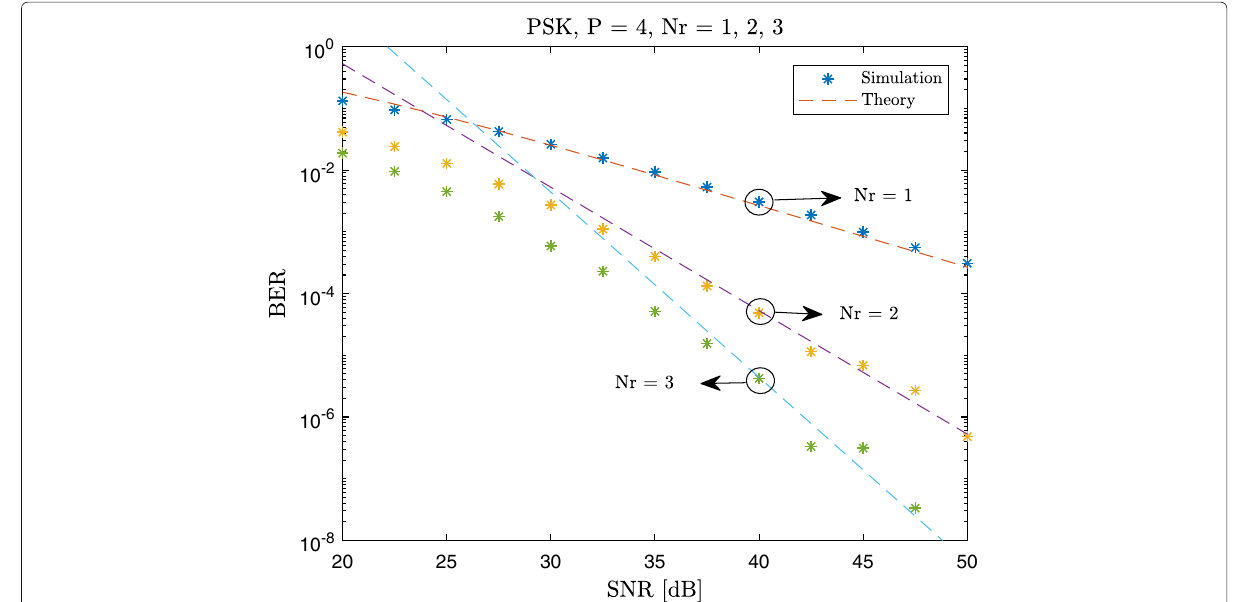
Fig. 10 ABEP of RecAnt-SM ( P = 4, N r = 1,2,3, M = 2 (BPSK)). The results are obtained by using RP 1 -RP